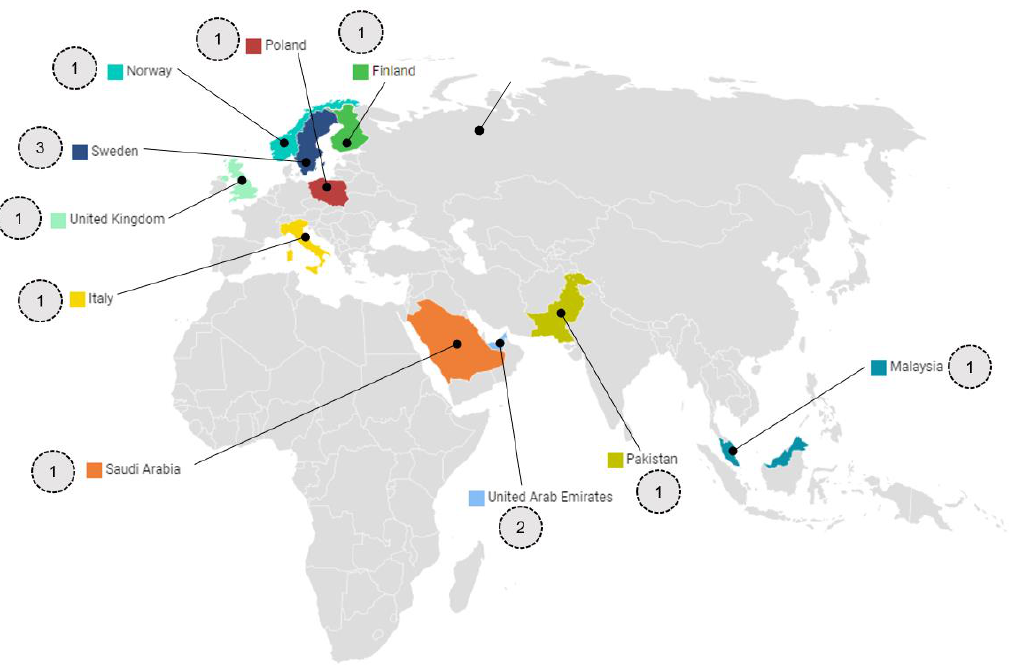
Figure 1. The geographical distribution of the authors and their institutions. Created with Datawrapper.